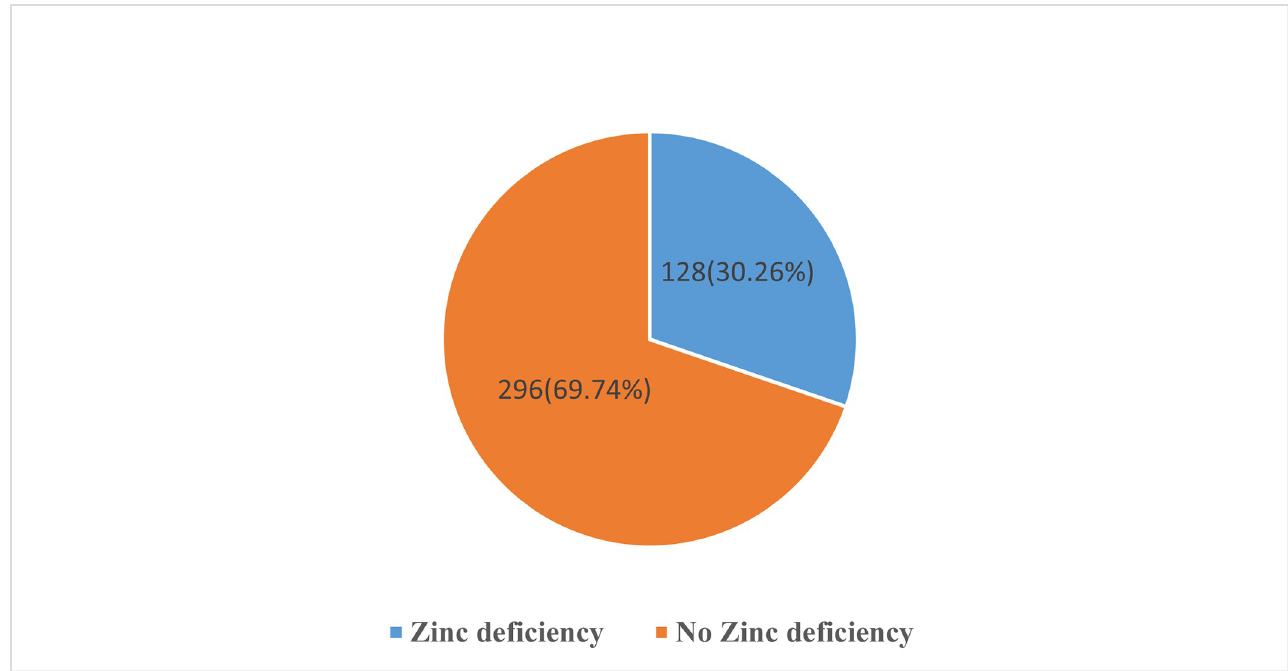
Fig 1. Prevalence of Zinc deficiency among pregnant women (n = 424) attending antenatal care clinics of Konso Zone in public health facilities Southern Ethiopia, 2020.